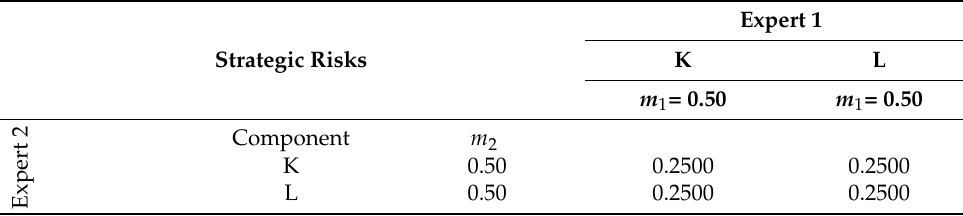
Table 11. Dempster combination of Expert 1 and Expert 2 for strategic risks.